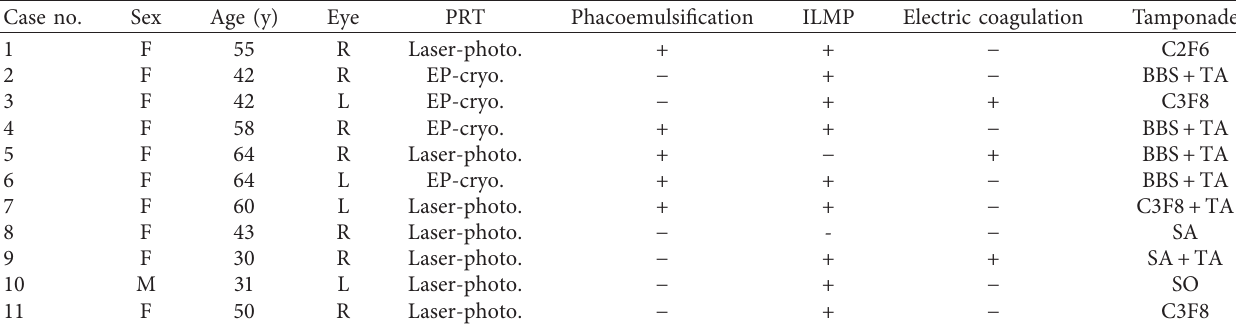
Table 2: Summary of patients’ surgical procedures.